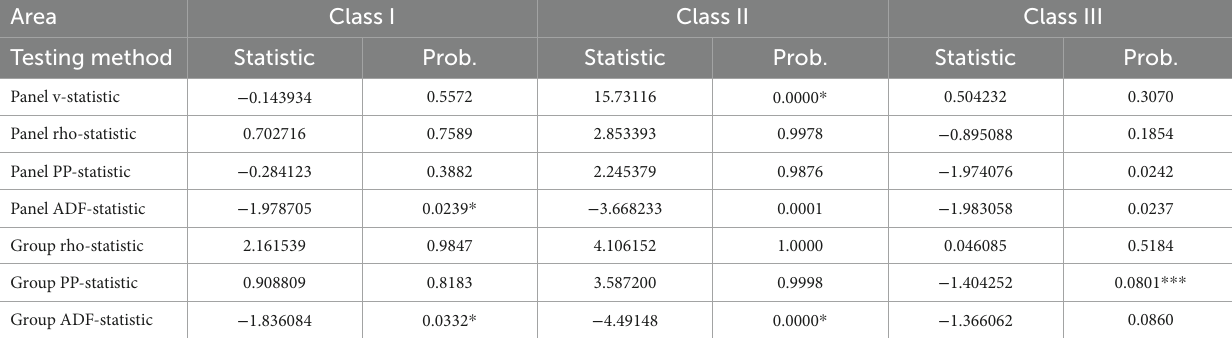
TABLE 4 E-G cointegration test results for various